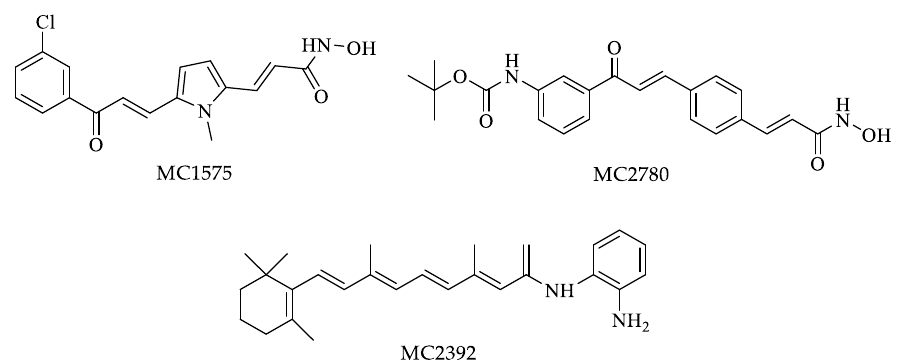
Figure 9. HDAC inhibitors active against Leishmania spp .